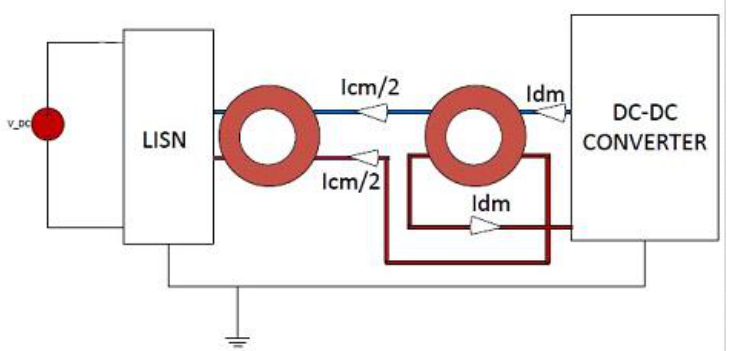
Figure 9. Test bench for conducted emission measurements with current probes.